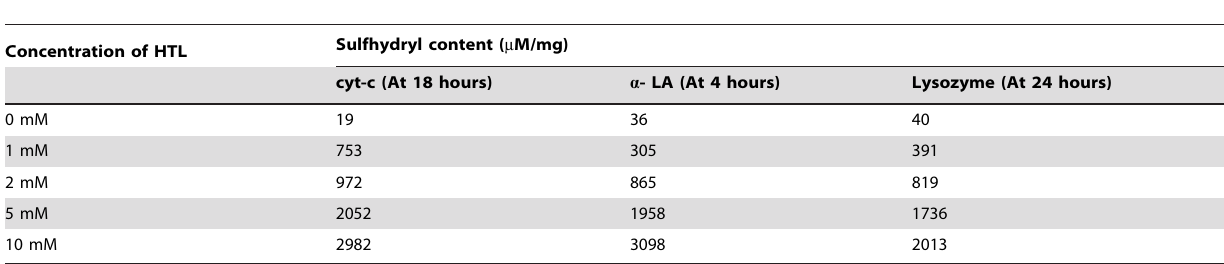
Table 2. Sulfhydryl content measurement of HTL treated cyt-c, a -LA and lysozyme*.